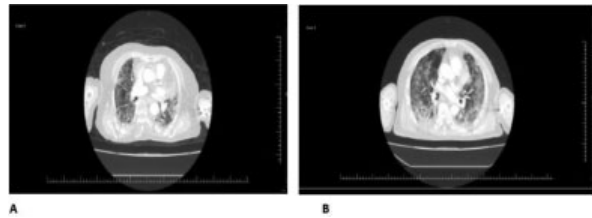
twice daily. On the day of starting this treatment, the sO 2 level was 91% (with a 10 L NRB facemask O 2 supply). The day